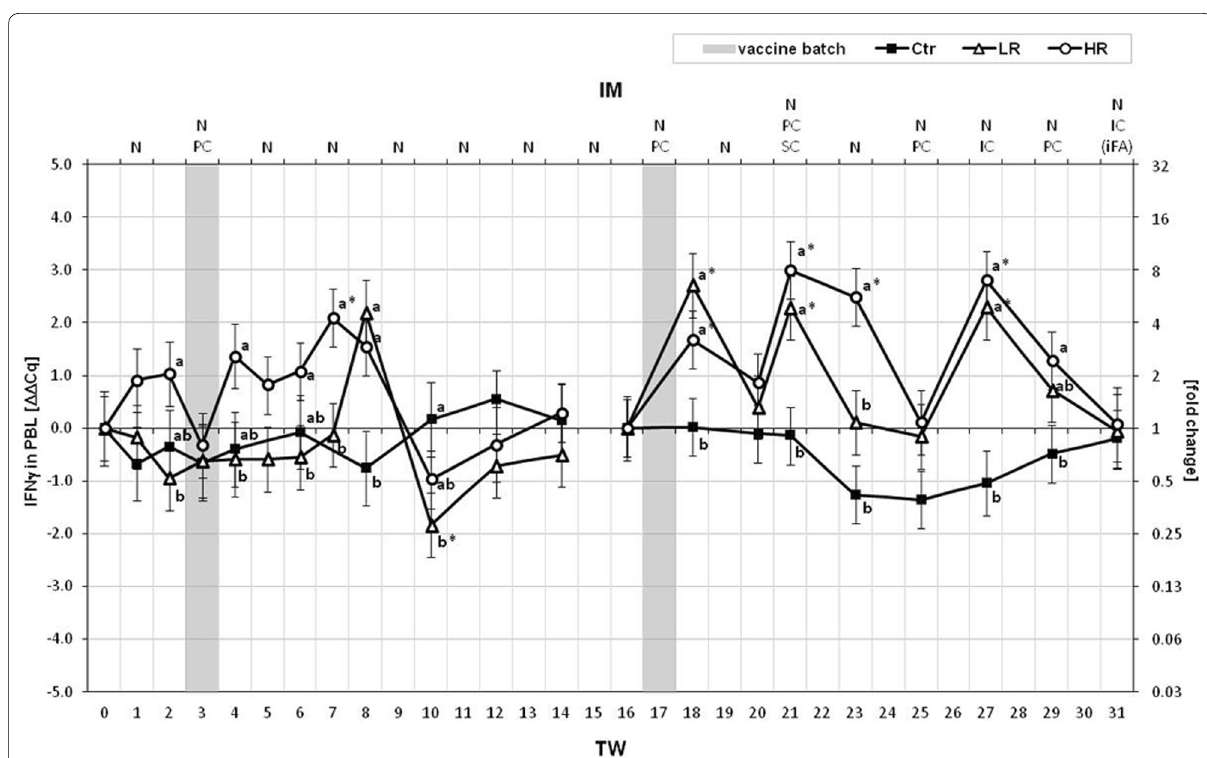
Fig. 1 IFNγ gene expression in PBL. The ΔΔCq values of IFNγ as LSM SD and the corresponding fold changes are mapped on the ordinates for ± the control (“Ctr”, n 5) and the treated animal groups (“LR”, low responder cows, n 4; “HR”, high responder cows n 5). The lower X-axis shows = = = the 31-week treatment period (TW). The upper X-axis depicts the immunization (IM) specified by the routes of vaccine application [nasal (N), percutaneous (PC), subcutaneous (SC) and intracutaneous (IC)] per TW. Incomplete Freund’s adjuvant (iFA) was solely part of the MucoCD - I vaccine in TW 31. The gray bars in TWs 3 and 17 highlight the times of the first uses of vaccine batches A and B, respectively. During the treatment periods with both vaccine batches and the particular TW before the first use of vaccine batch A or B, substantial differences within the same group are marked by asterisks ( p < 0.05). Lower case (a, b, c) indicate evident differences ( p < 0.05) between the groups on the same